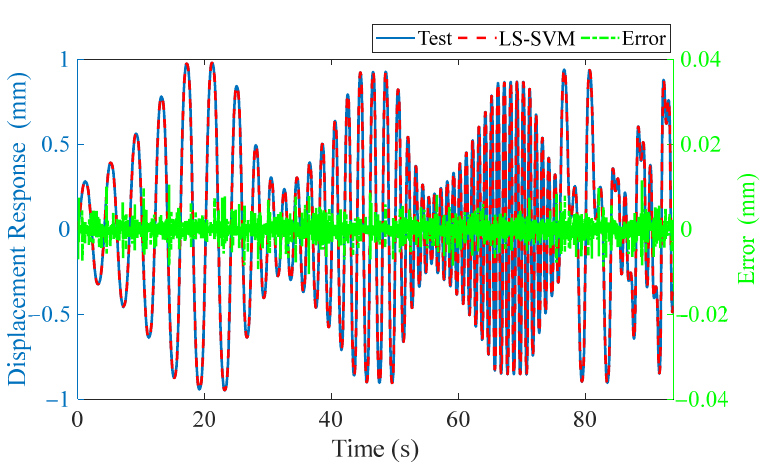
Figure 9. Results comparison of trained LS-SVM and experiment.